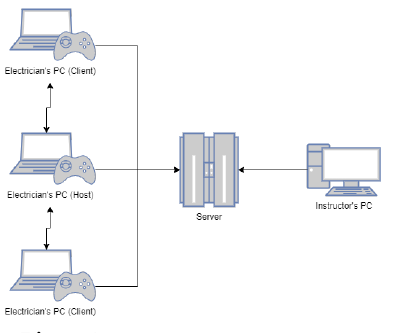
Figure 1. Overall architecture of the project.